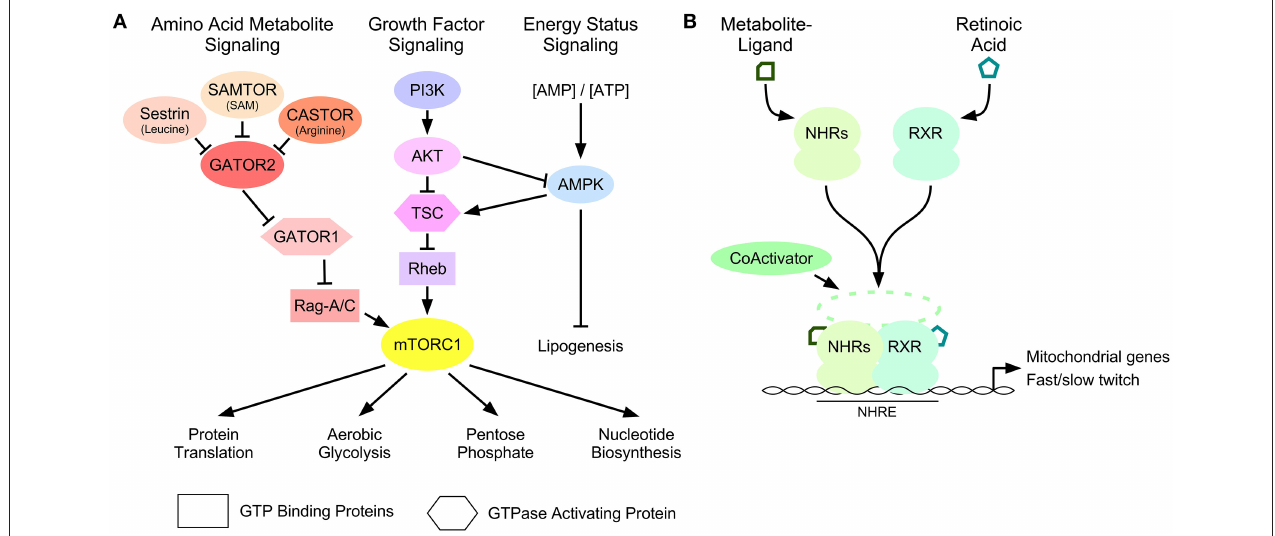
FIGURE 1 | Metabolite-dependent mechanisms that influence muscle fiber composition. (A) The mTORC1 signal transduction pathway is controlled by amino acid-, growth factor- and energy-dependent signaling mechanisms. Amino acid-dependent signaling through Sestrin, CASTOR, and SAMTOR, repress GATOR2-dependent inhibition of GATOR1 GAP activity toward Rag GTP-binding proteins. Growth factor signaling through the phosphatidylinositol 3 kinase (PI3K): AKT pathway inhibits the GAP activity of the tuberous sclerosis complex (TSC) toward Rheb. These pathways lead to the stimulation of mTORC1 activity. Cellular energy status controls mTORC1 through a regulatory loop between the growth factor signaling pathway and the sensor of AMP called AMPK. Downstream targets of mTORC1 control protein translation and metabolic pathways that provide the substrates required for growth. (B) Ligand activation of nuclear hormone receptors (NHRs), including PPAR δ and TR α , and form a heterodimer with retinoic acid receptor (RXR) that recruits coactivator proteins to the nuclear hormone response elements (NHRE) of the promoters of genes involved in mitochondrial gene expression and skeletal muscle fiber-type